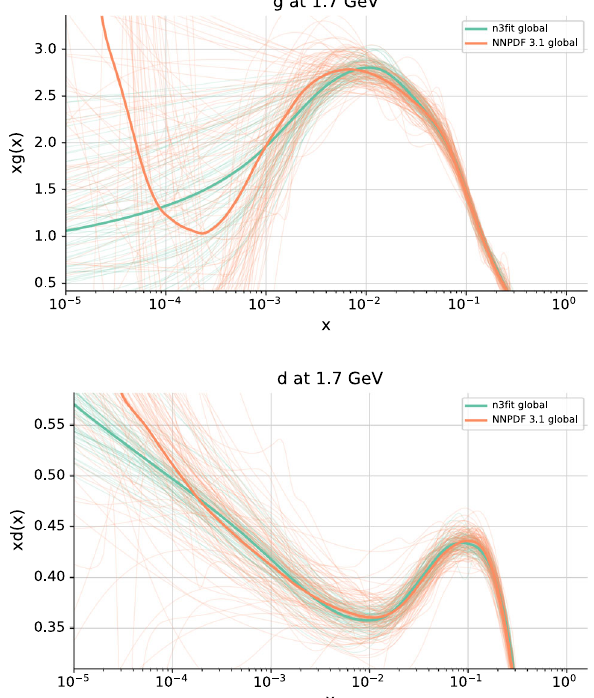
Fig. 9 Comparison of the PDF of the gluon and the d -quark for the global setup. Each line correspond to a different replica while the bold-